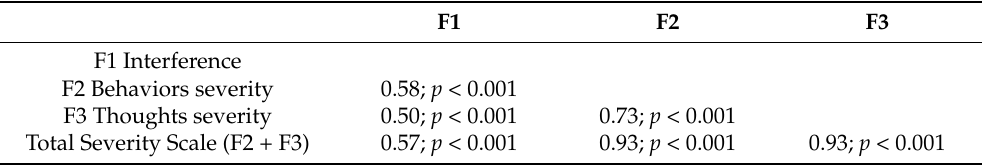
Table 1. Spearman coefficient correlations between POCS factors.